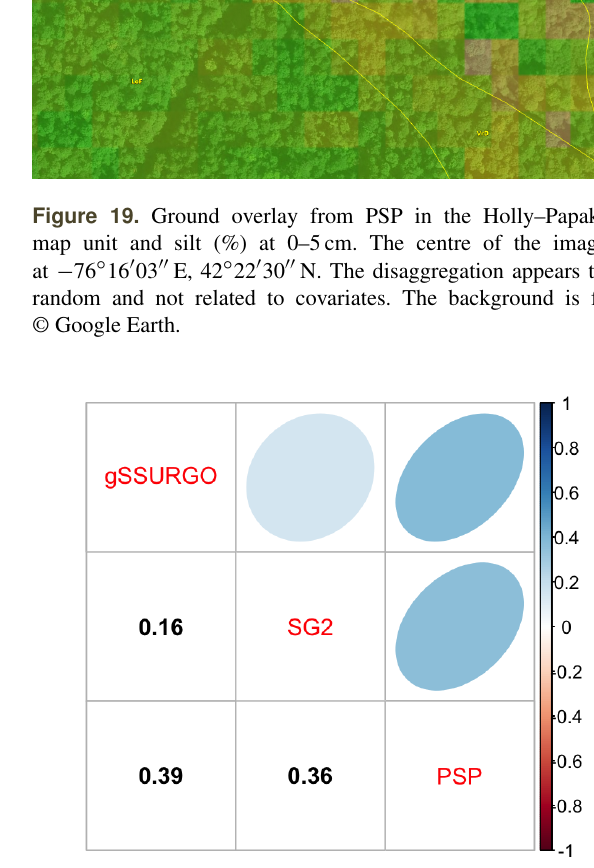
Figure 20. Pearson correlations between local products for pH at 0–5cm. These are moderate but weak for gSSURGO vs.